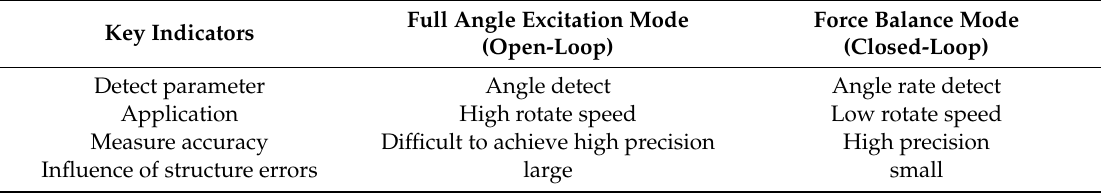
Table 1. MEMS DRG performance comparisons of di ff erent working